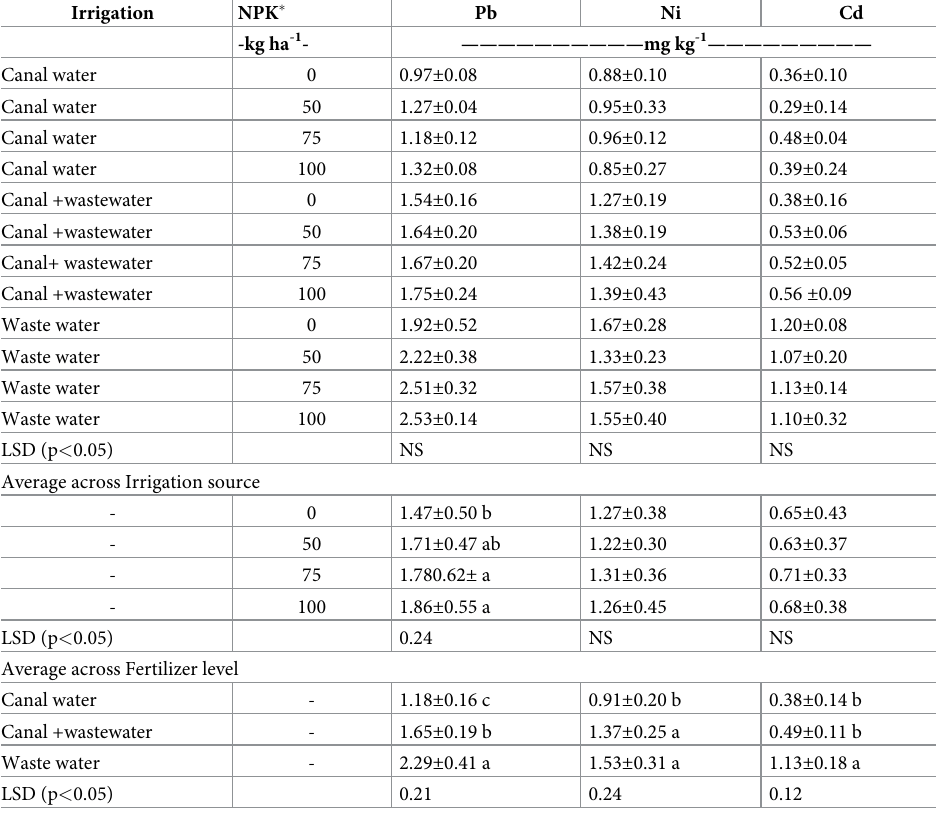
Table 8. Grain heavy metal (Pb, Ni and Cu) as influenced by NPK levels and irrigation source.